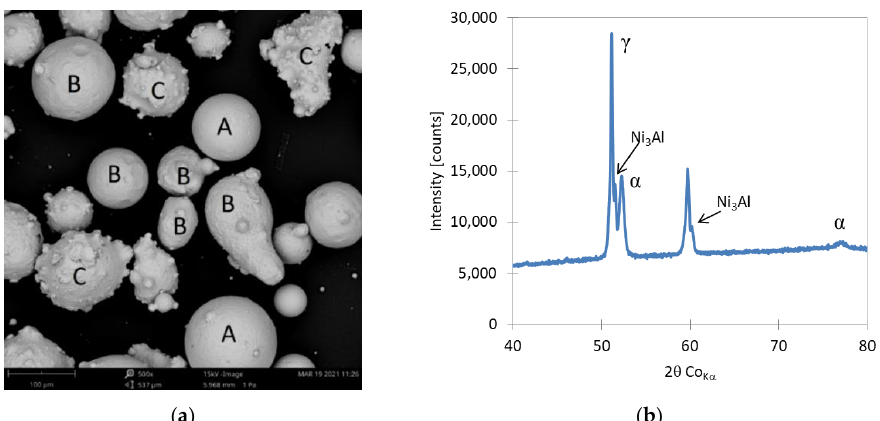
Figure 7. ( a ) SEM image of metal particles; ( b ) X-ray diffractogram of metal particles: α —bcc phases; γ— fcc phases.